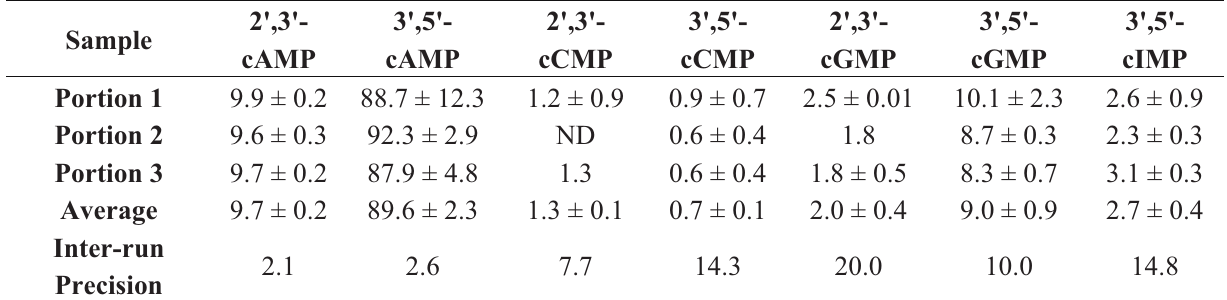
Table 2. Reproducibility of the method. A rat brain was split into three portions, and cNMPs were extracted and quantified independently. Results are reported in pmol/g of